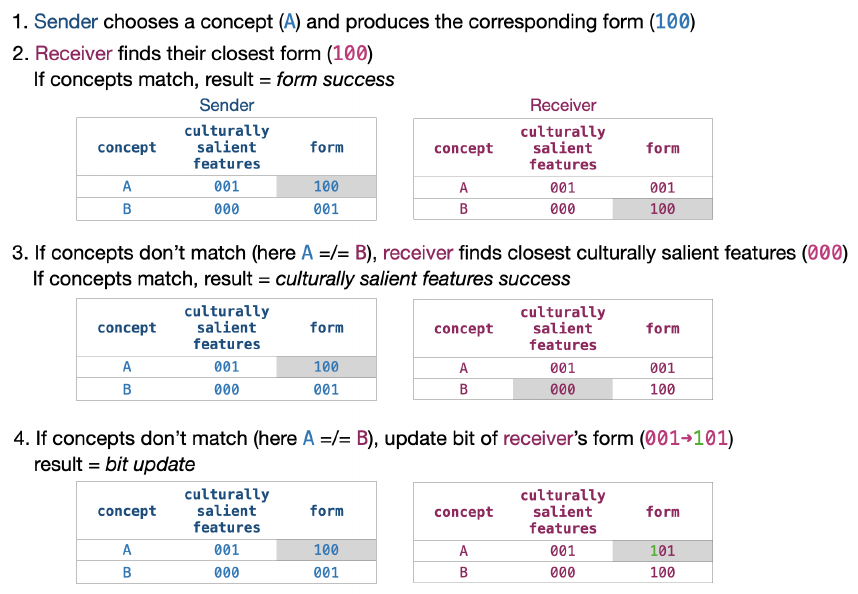
Figure 5. The steps of the language game with an accompanying